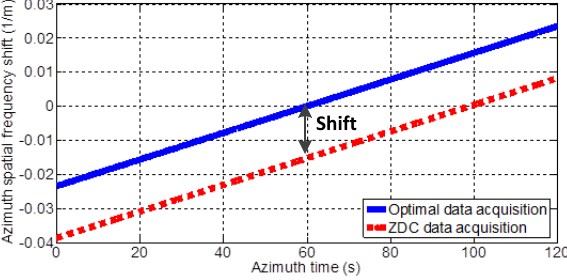
Figure 7. Azimuth spatial spectral shifts corresponding to two data acquisition methods.